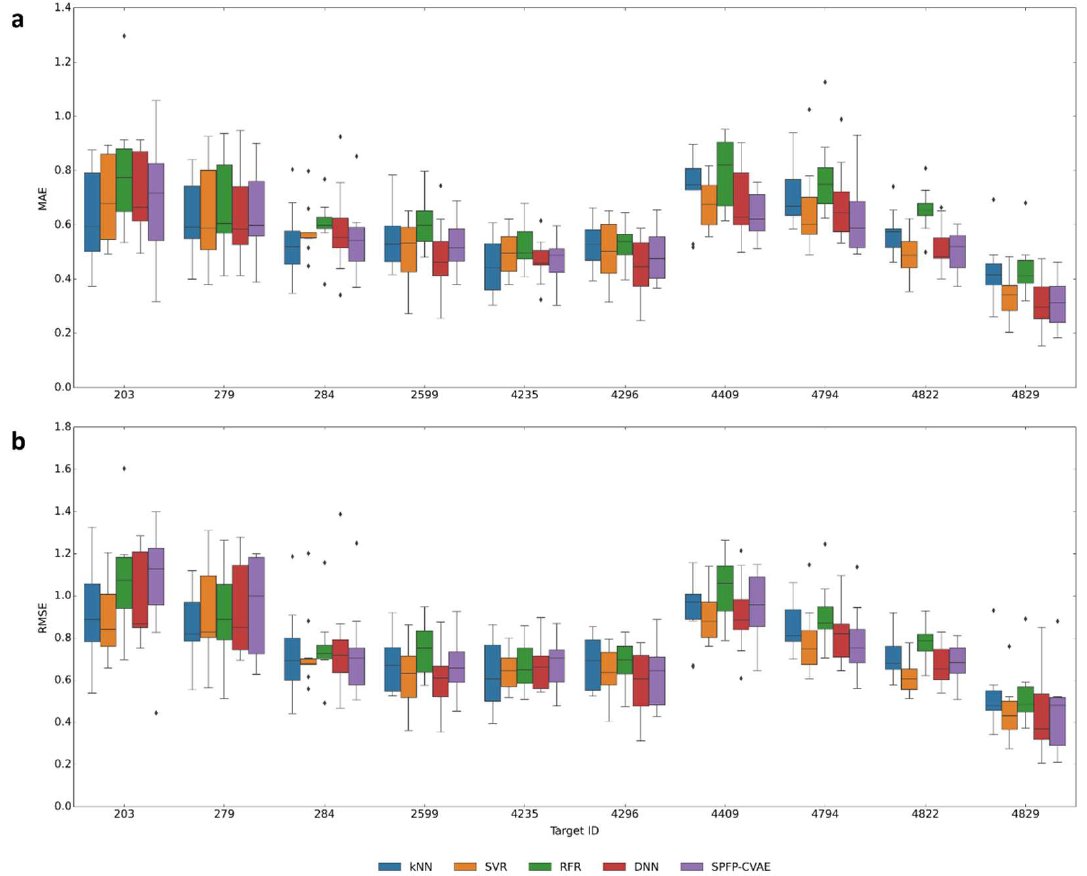
Figure 8. Prediction accuracy for the most potent test compounds. Boxplots report the median MAE ( a ) and RMSE ( b ) values for the 10% most potent test compounds from all classes and different ML models including kNN.